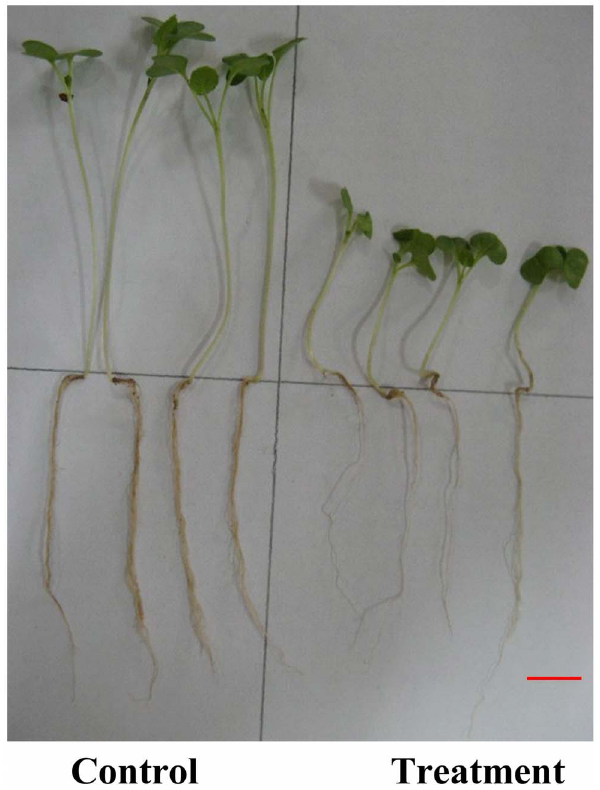
Figure 4. The effect of waterlogging on seedlings of B108 at the seedling stage.